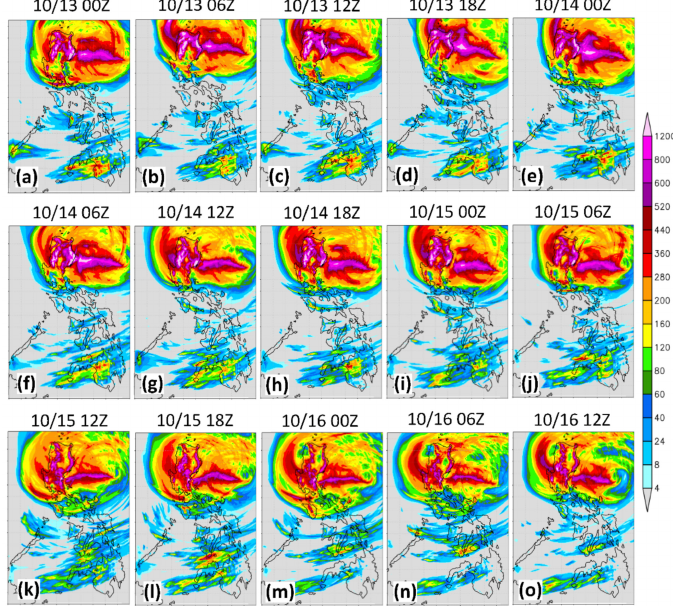
Figure 10. As in Figure 5, except for predicted 72 h rainfall distributions (mm), all valid for the period from 1200 UTC on 16 to 1200 UTC on 19 October during TY Koppu (2015), with the time-lagged forecasts every 6 h from ( a ) 0000 UTC on 13 to ( o ) 1200 UTC on 16 October 2015, respectively. Some panels were shown in Part I